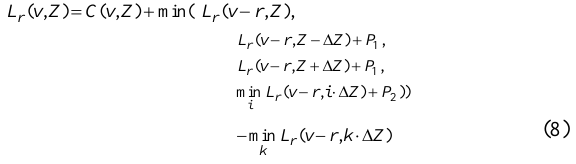
Figure 1. Calculation of matching costs for a voxel If window-based cost functions are used (e.g. Census or normalized cross-correlation, NCC) the matching window is defined in object space parallel to a reference plane which is the X/Y-plane of the global (for 2.5D applications) or a local (for 3D application) coordinate system. In a next step the matching window is re-projected into all images and the grey or colour values underneath the re-projected windows are used for cost calculation. This is important because it leads to a high invariance against image rotations and (within limits) to different images scales. Therefore, images with larger baselines can be combined whereas stereo SGM typically uses image pairs with short baselines for pairwise